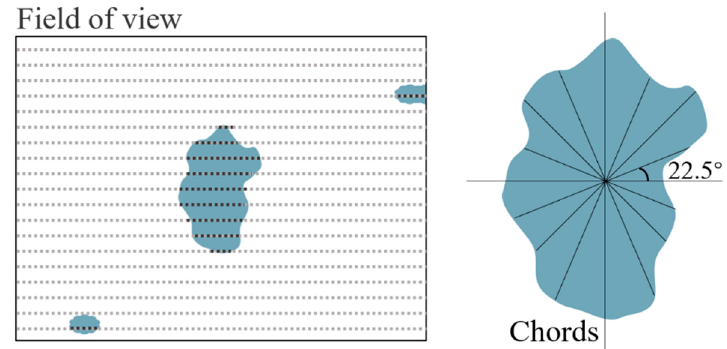
Figure 3. Testing principle of automated inclusion analyzer.